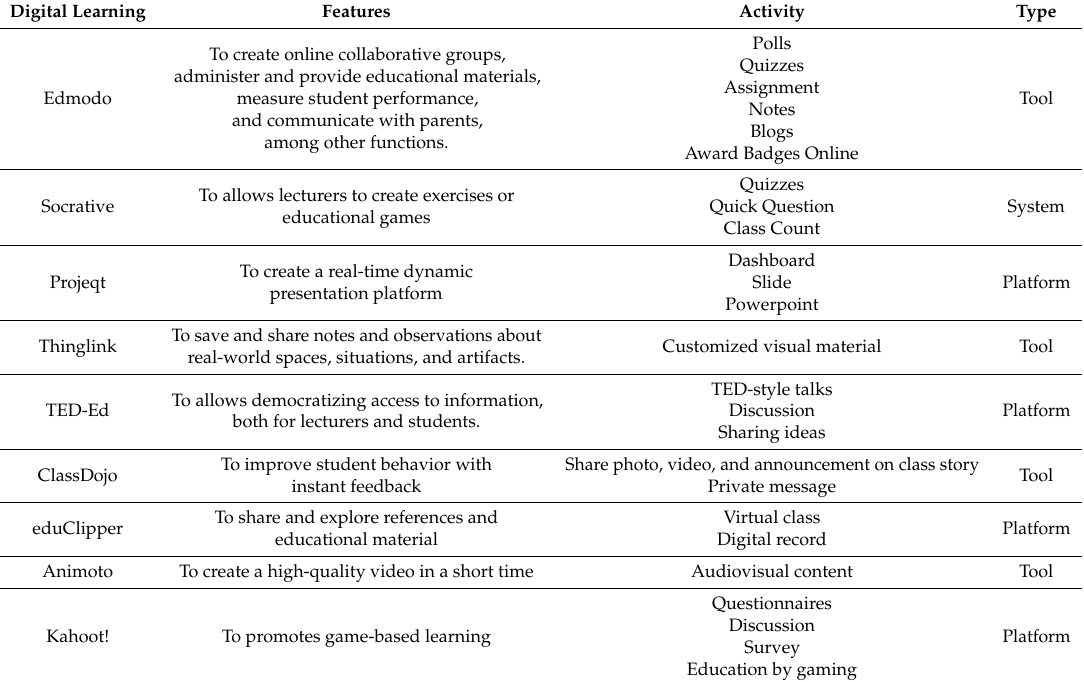
Table 1. Digital learning platforms and tools